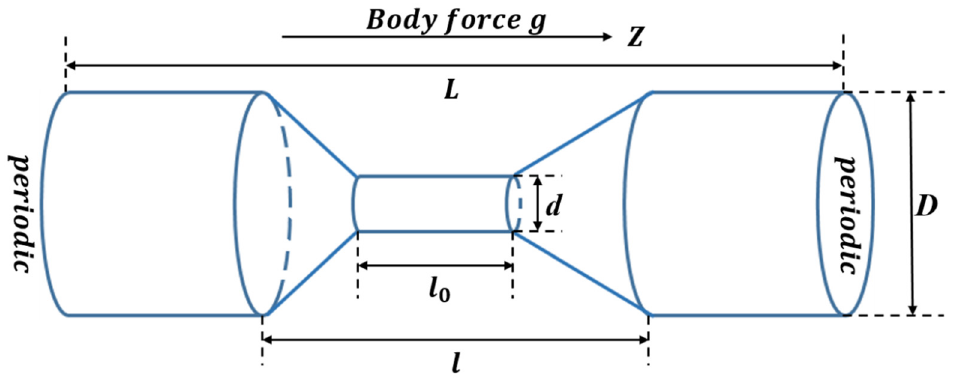
Figure 1. Schematic representation of simulation model for funnel-shape fluidic channel.